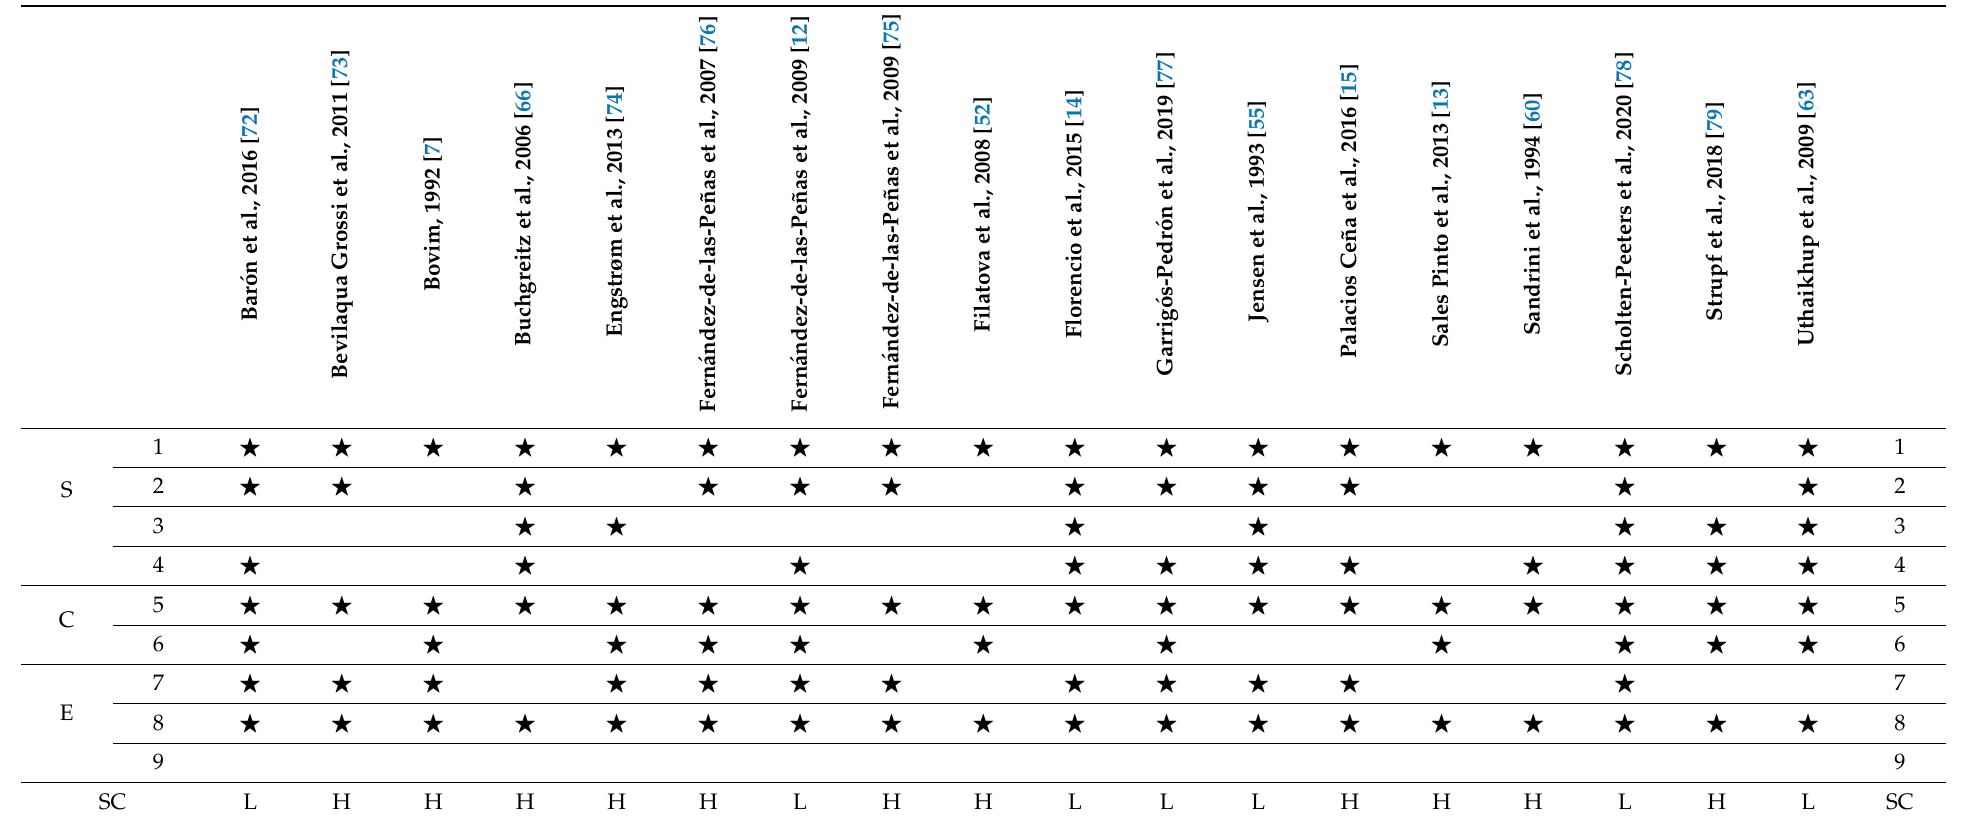
Table 6. Risk of bias (the Newcastle-Ottawa Scale) of the included studies in including women with